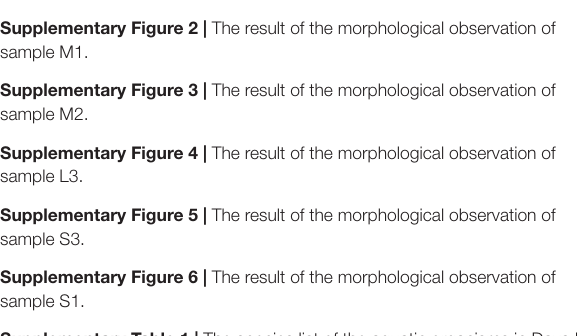
Supplementary Figure 1 | The result of the morphological observation of sample L1. Supplementary Figure 2 | The result of the morphological observation of sample M1. Supplementary Figure 3 | The result of the morphological observation of sample M2. Supplementary Figure 4 | The result of the morphological observation of sample L3. Supplementary Figure 5 | The result of the morphological observation of sample S3. Supplementary Figure 6 | The result of the morphological observation of sample S1. Supplementary Table 1 | The species list of the aquatic organisms in Daya Bay. Supplementary Table 2 | The abundance of identified species in the eukaryotic composition of the stomach contents. Supplementary Table 3 | The abundance of identified species in the stomach microbiome of the stomach